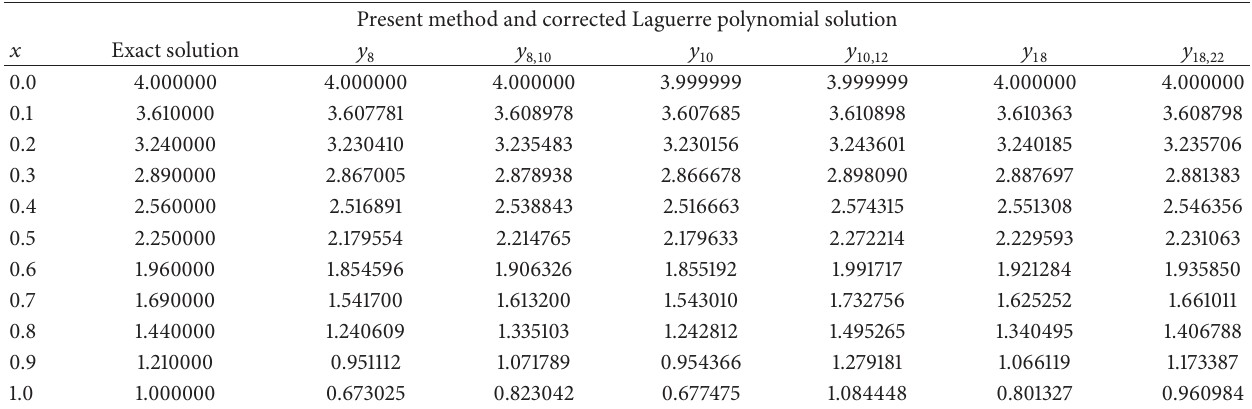
Table 3: Numerical solution of Example 5 for different 𝑁